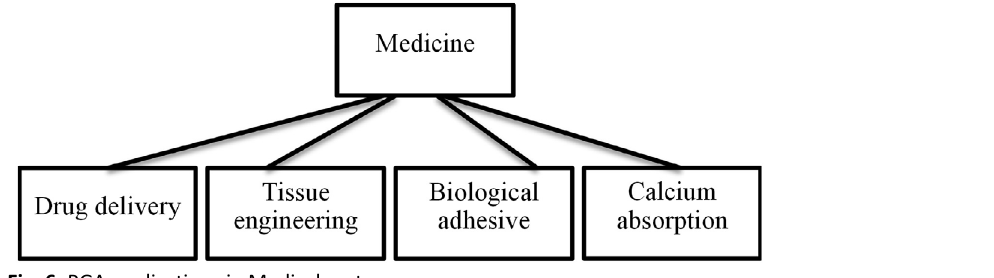
Fig. 6. PGA applications in Medical